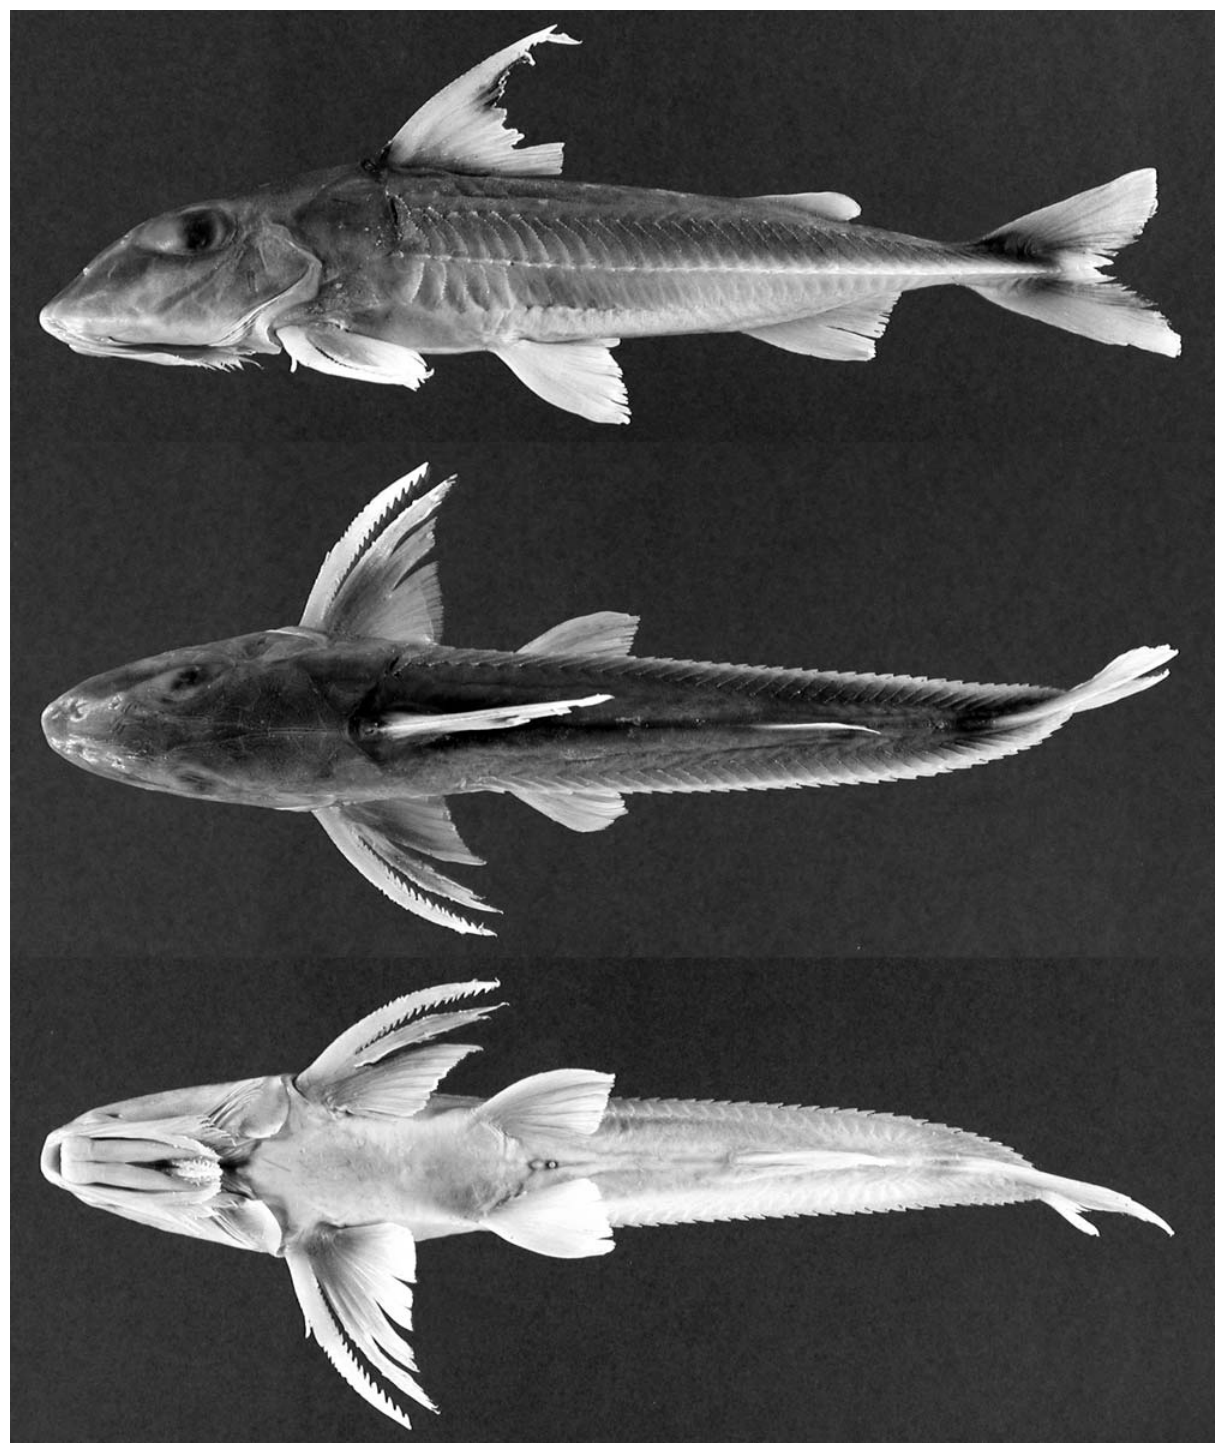
Fig. 12. Leptodoras hasemani , ANSP 175885 (SL 156.4 mm), Essequibo river (Atlantic dr.),